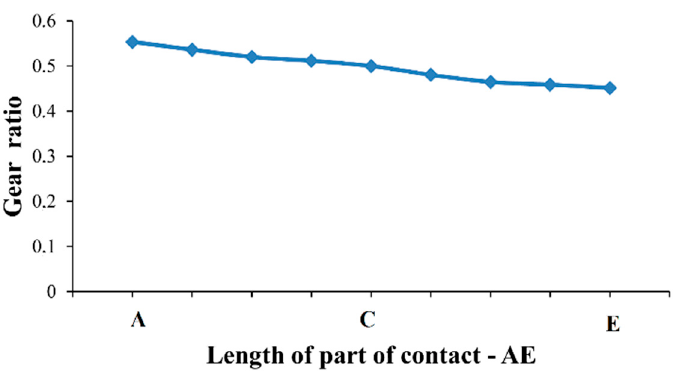
Figure 22. The length of part of contact.